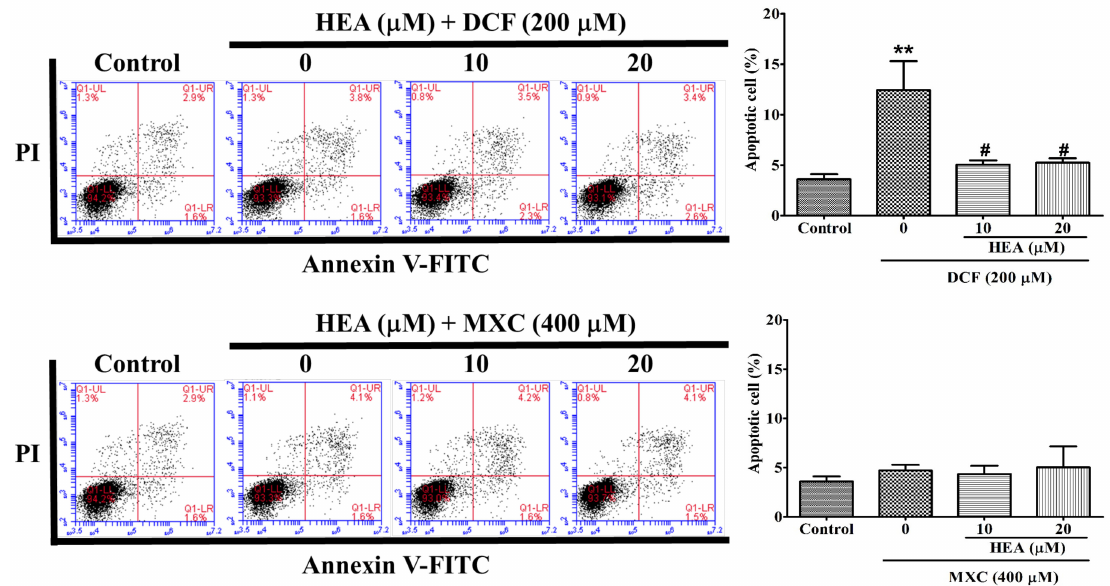
Figure 4. Effects of HEA on the apoptosis of HK–2 cells induced by DCF and MXC. HK–2 cells were pretreated with HEA (10 and 20 µ M) for 2 h and then exposed to DCF (top panel) or MXC (bottom panel) for 24 h and subjected to Annexin V-FITC/propidium iodide (PI) double staining assay (left panel). The quantitative analysis of survival and apoptotic cells were performed in triplicate (right panel). Abscissa FL–1: Annexin V-FITC. Ordinate FL–2: PI. Values are expressed as mean ± SD (** p < 0.01 versus the control group; # p < 0.05 versus the DCF only